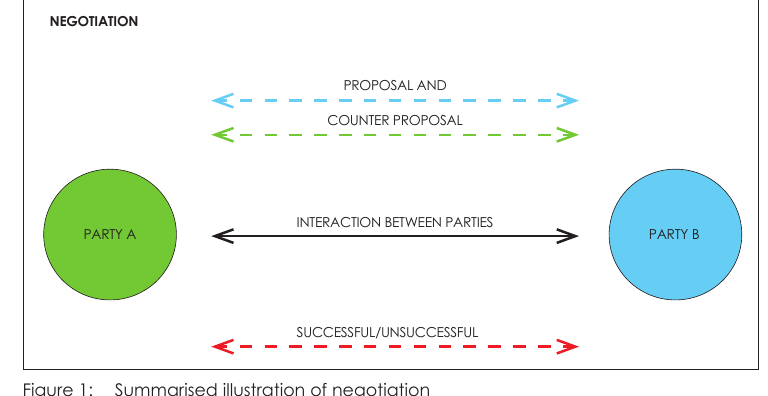
Figure 1: Summarised illustration of negotiation